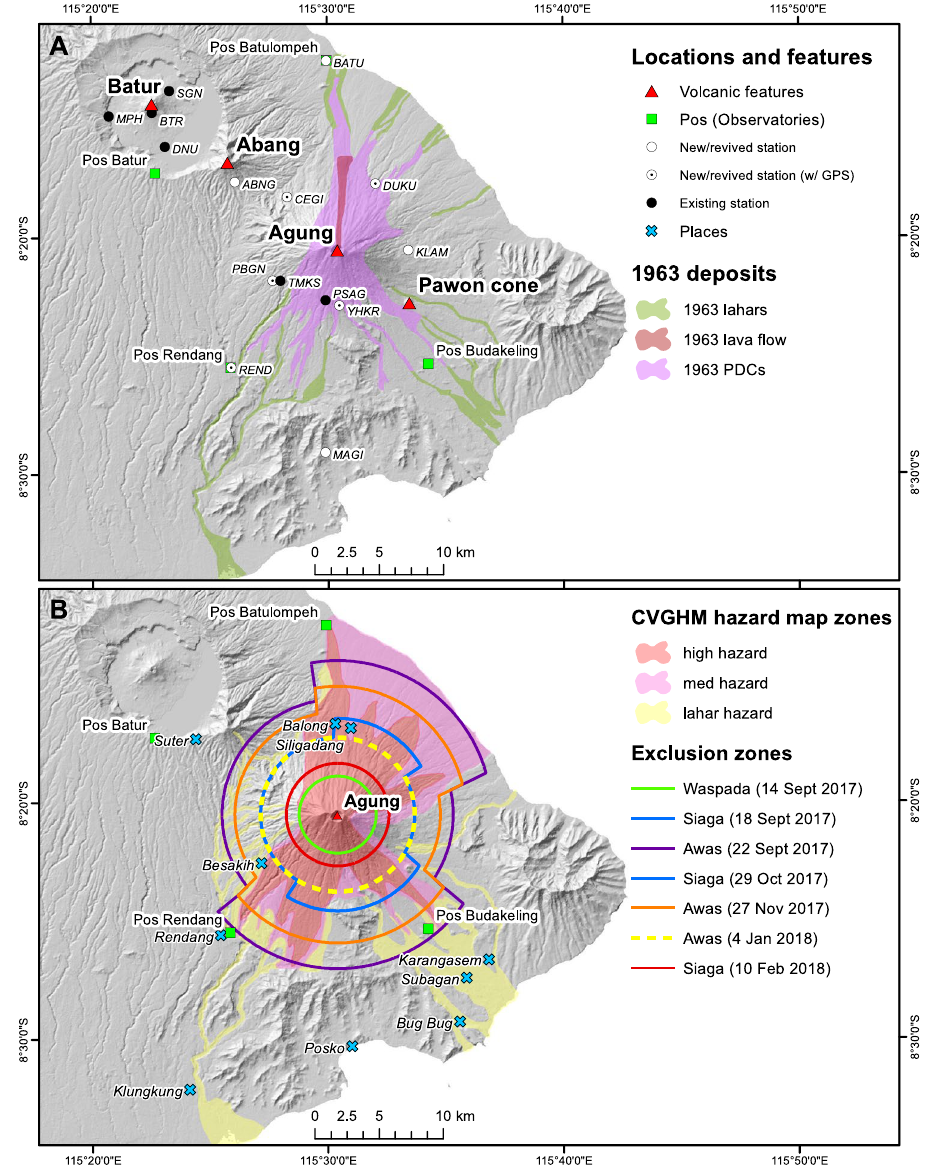
Figure 1. Maps of Agung. ( A ) Location map of the area surrounding Mount Agung, in eastern Bali. Volcanic features (red triangles), locations of the observatories (pos, green squares), and relevant towns (blue crosses) are overlain on a Shuttle Radar Topography Mission (SRTM) 30 m DEM. The 1963 lava flow, pyroclastic density current, and lahar deposits are modified from 2 . ( B) CVGHM hazard zones from the published hazard map 39 are shown along with the exclusion zones established through the crisis. Note that the 18 September and 29 October exclusion zones (in blue) are the